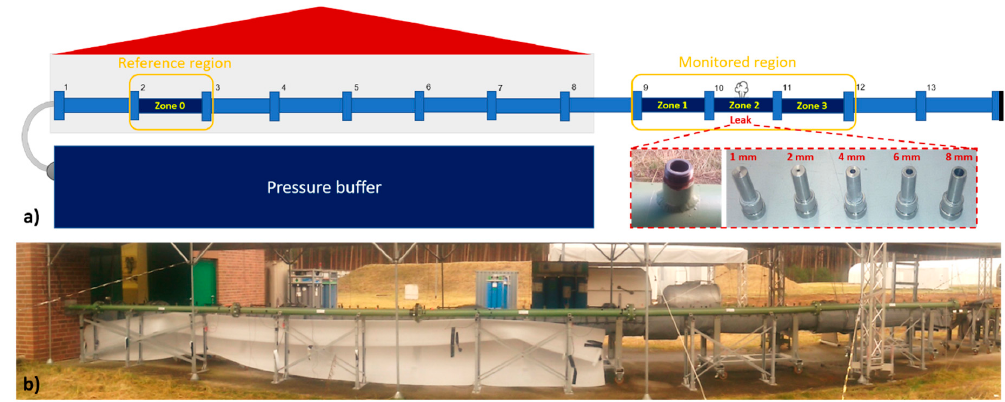
Figure 1. ( a ) Schematic illustration of the used pipeline system highlighting pipe zones instrumented with optical fiber. Inlay: pipeline side adapter and holey adapter caps used to simulate the leak in the pipeline; ( b ) Photo of the outside part of the pipeline system, where the main measurement region instrumented with the optical fiber was